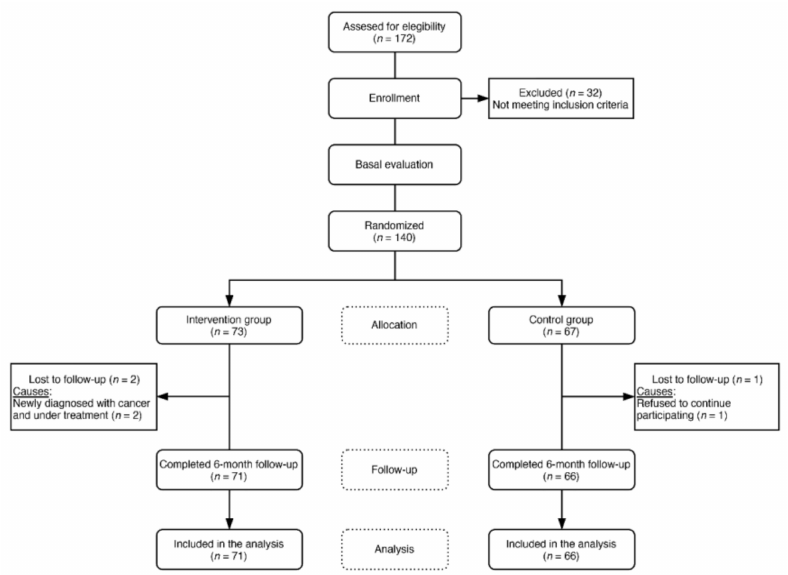
Figure 1. Flow chart of postmenopausal women through the